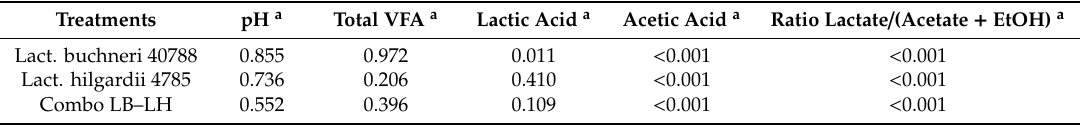
Table 1. Results of the mixed e ff ect model analysis for comparison of the fermentation profiles at all opening periods between the control and the bacterial inoculation